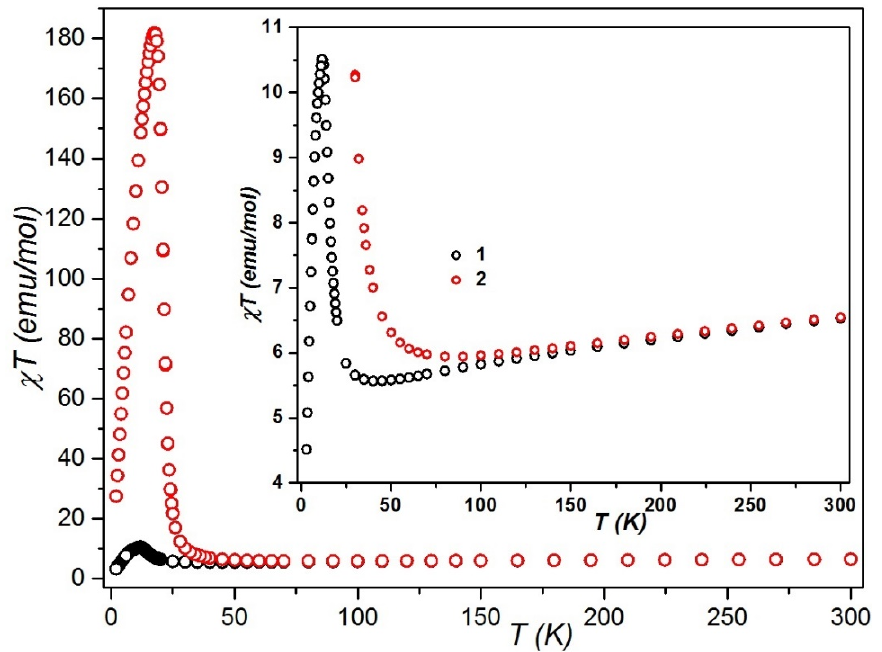
Figure 4. Magnetic dc plots for 1 and 2 . Temperature dependencies of χ T at H = 1000 Oe. Inset: zooms magnetization versus the field at T = 2 K.